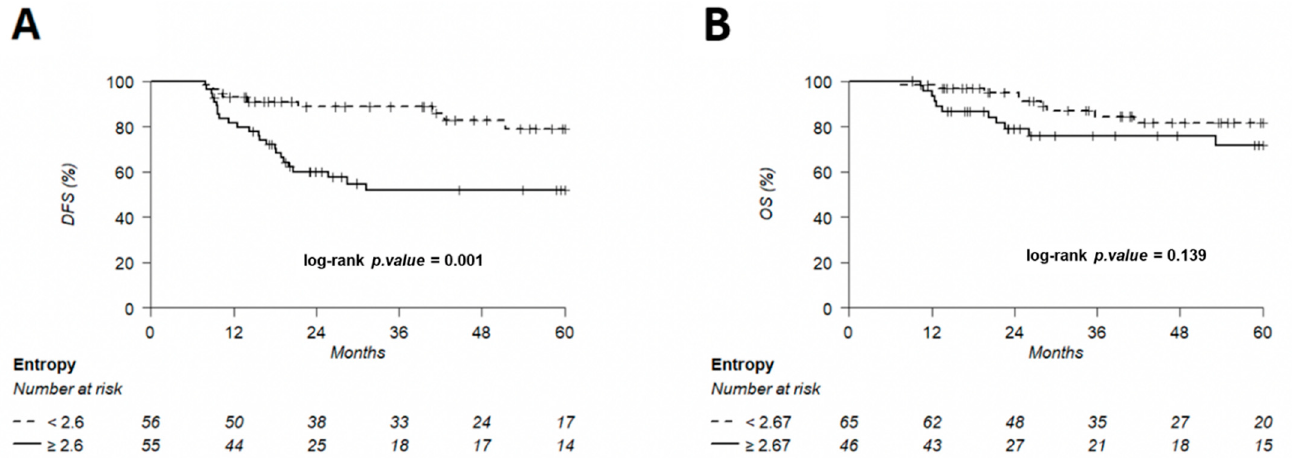
Figure 10. Kaplan–Meier of DFS ( A ) using an entropy threshold of 2.6 and OS ( B ) using an entropy threshold of 2.67, predetermined using Young’s index.